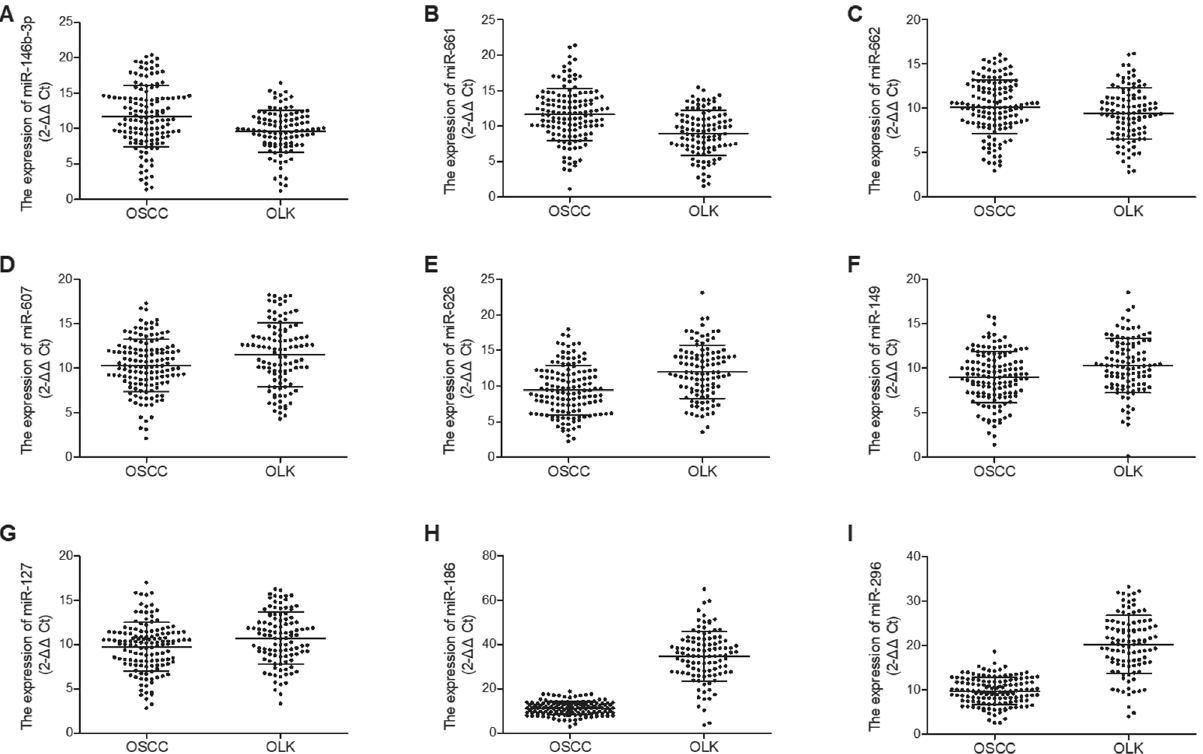
Figure 8. Among all candidate miRNAs, only the expression of miR-186 and miR-296-5p was reduced in saliva of OSCC patients compared with that in OLK patients. ( A ) The expression of miR-146b-3p was comparable in saliva of OSCC patients and OLK patients; ( B ) The expression of miR-661 was comparable in saliva of OSCC patients and OLK patients; ( C ) The expression of miR-662 was comparable in saliva of OSCC patients and OLK patients; ( D ) The expression of miR-607 was comparable in saliva of OSCC patients and OLK patients; ( E ) The expression of miR-626 was comparable in saliva of OSCC patients and OLK patients; ( F ) The expression of miR-149 was comparable in saliva of OSCC patients and OLK patients; ( G ) The expression of miR-127 was comparable in saliva of OSCC patients and OLK patients; ( H ) The expression of miR-186 was evidently